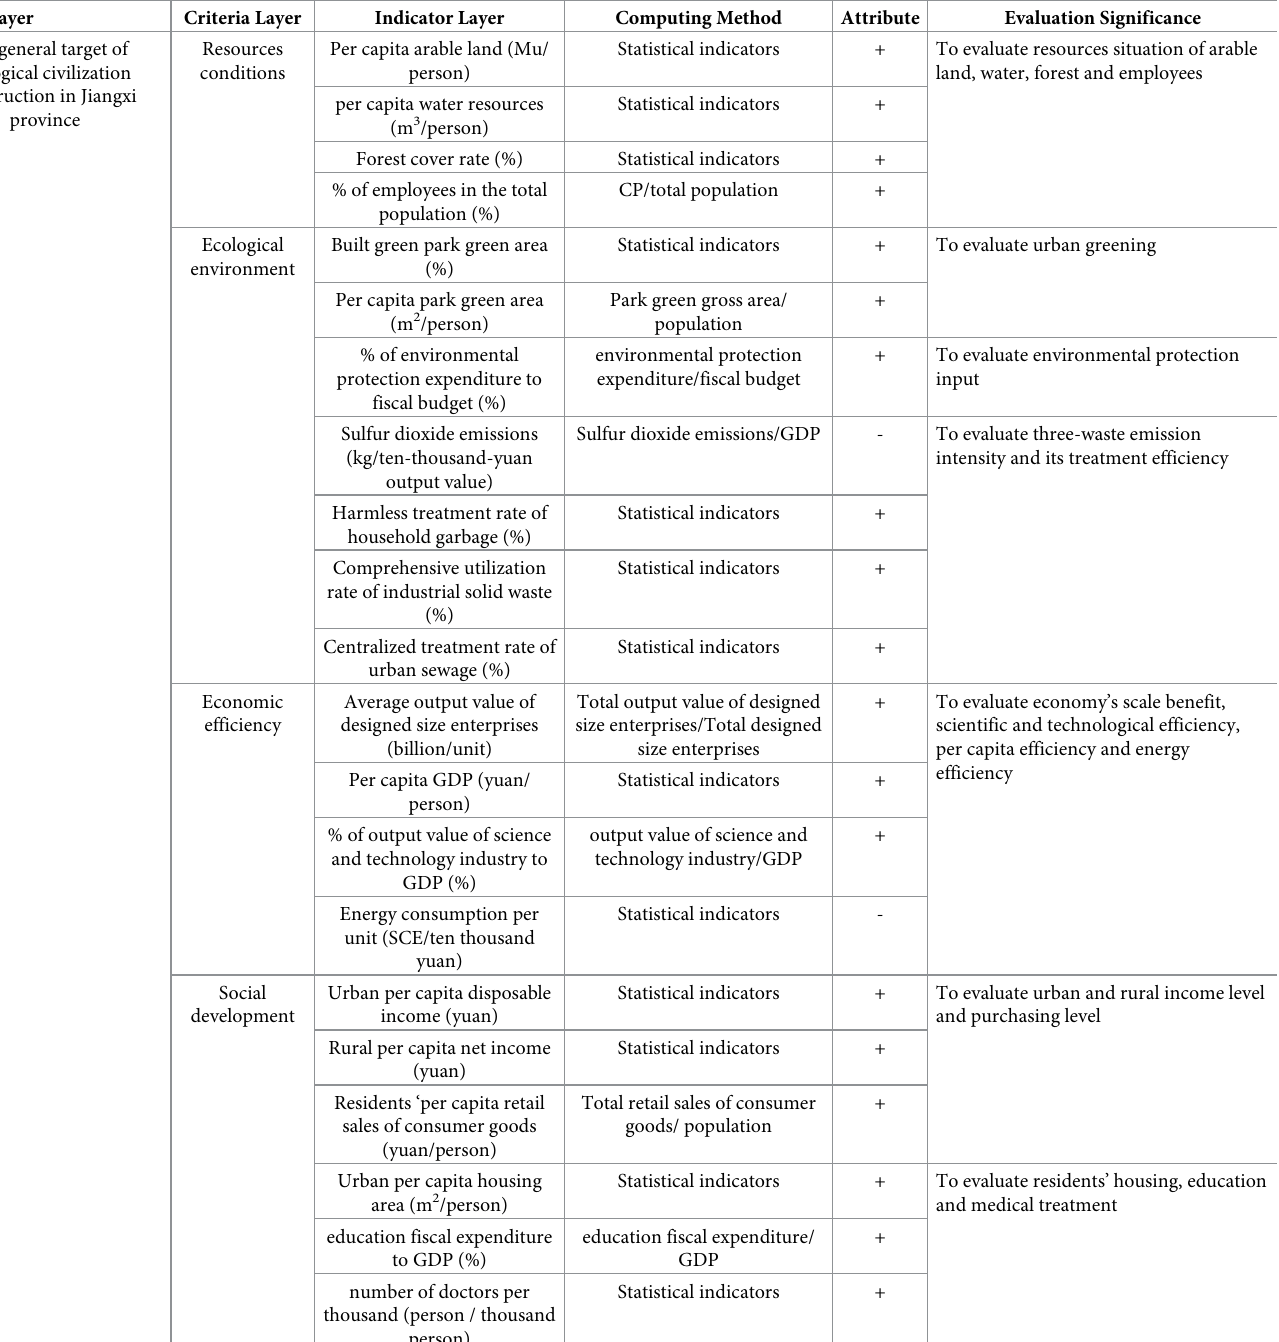
Table 1. Evaluation index system of the ecological civilization of Jiangxi